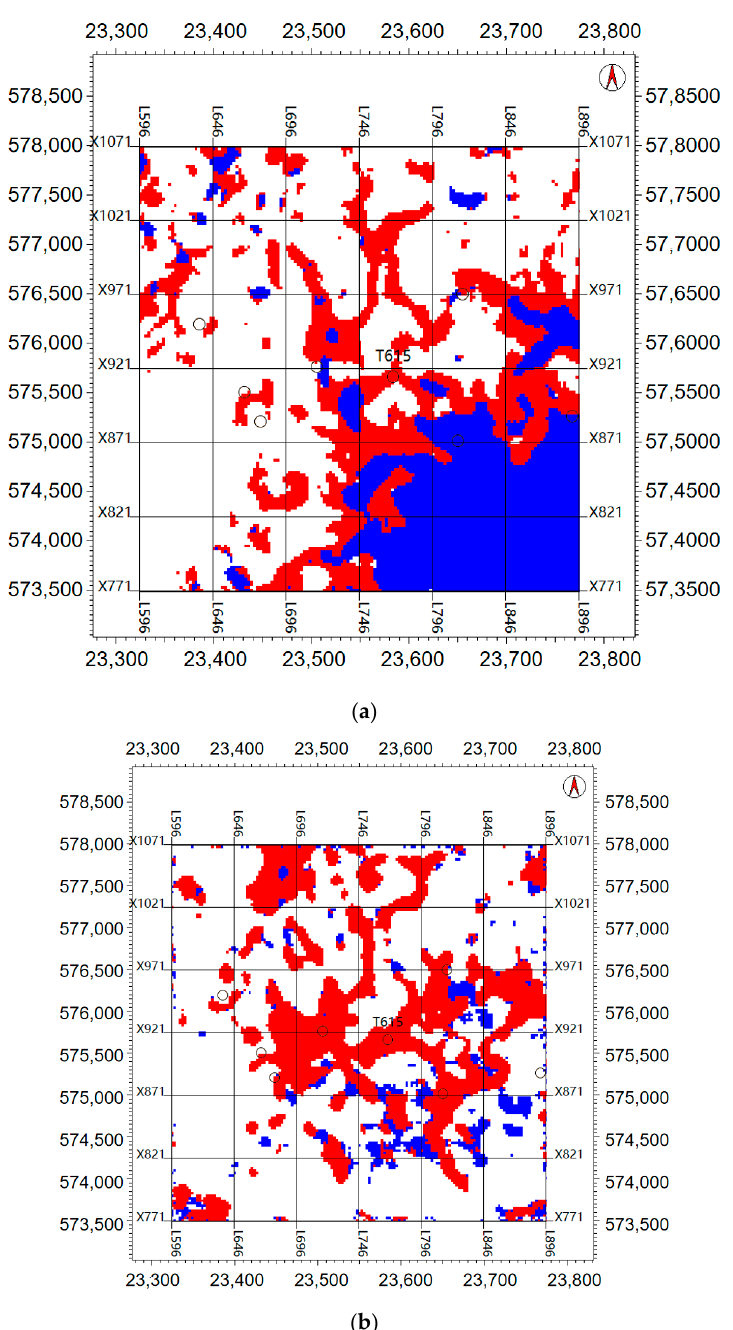
Figure 9. Waveform cluster results. ( a ) is obtained by the full-bands data; ( b ) is obtained by key time–frequency data.